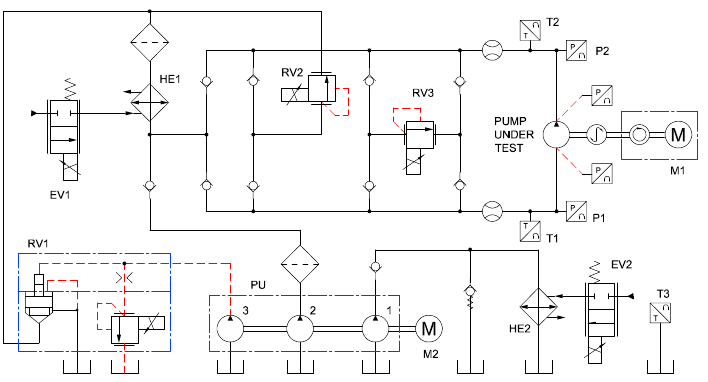
Figure 2. Layout of the test rig in the configuration for steady-state tests of hydraulic pumps.